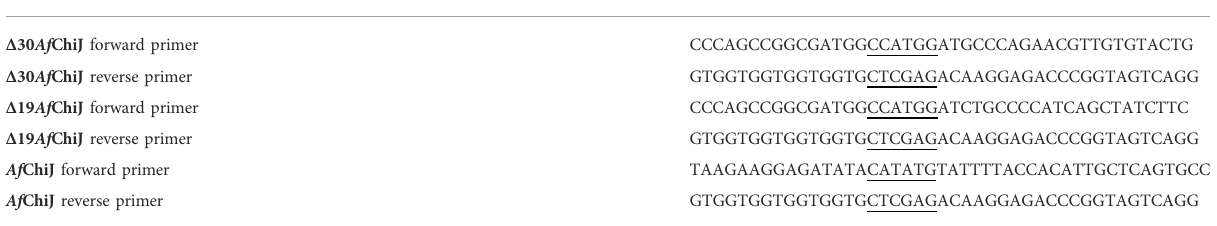
TABLE 1 Primer sequences used to amplify the chitinase